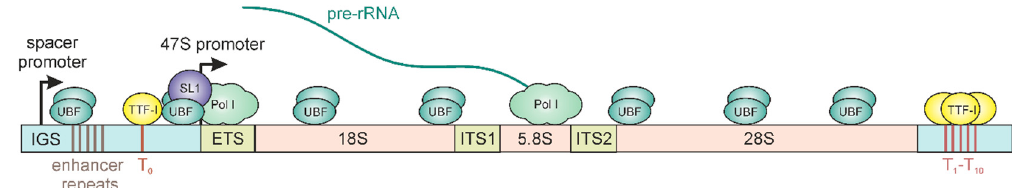
Figure 1. Scheme of a mouse rRNA gene with associated proteins. The pre-rRNA coding region consists of 18S, 5.8S and 28S rRNA sequences and transcribed ETS and ITS spacers. Individual rDNA repeats are separated by IGSs. Pol I transcription at the 47S promoter is initiated by specific set of proteins, which includes UBF and SL1 complex. The dimers of UBF are also associated with the pre-rRNA coding regions of active rDNA repeats. Transcription ends at multiple terminator elements (T 1–10 ) that bind TTF-I protein. In addition, TTF1 occupies a terminator-like sequence (T 0 ) near the rDNA promoter. IGSs also contain repetitive enhancer elements and spacer promoters, which in mice are located about 2 kb upstream of the pre-rRNA transcription start site.